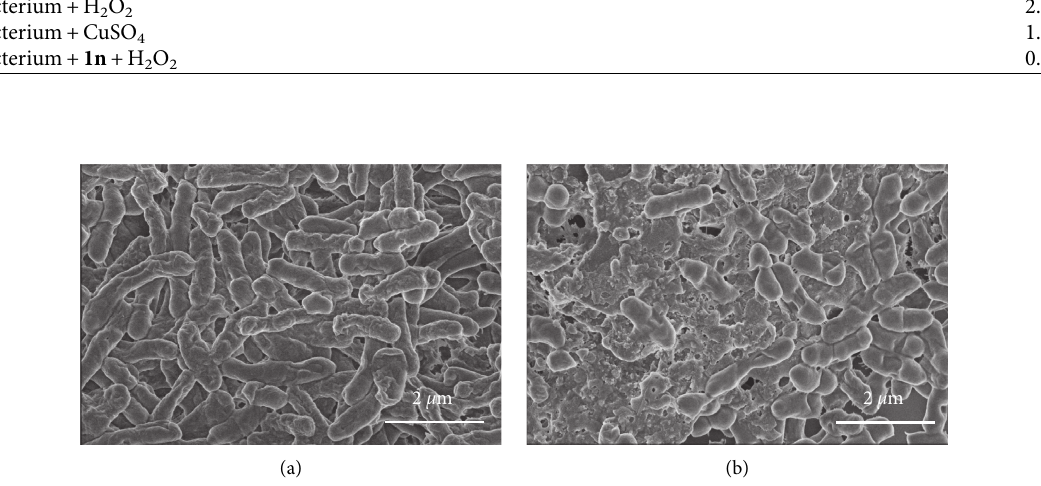
Figure 9: FESEM images of Sphingobacterium with no treatment (a) and after being treated with 100 μ L 1n +50 μ l H